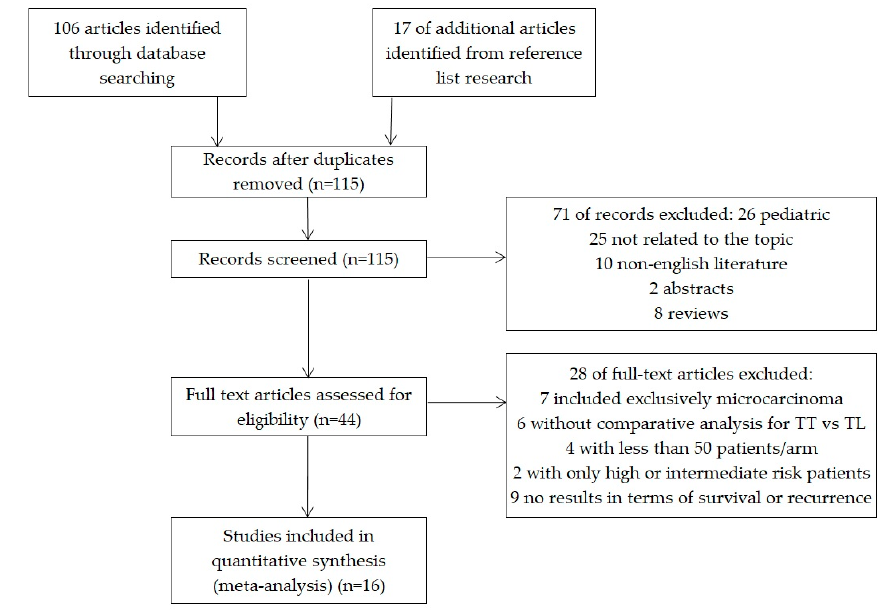
Figure 1. Flow chart for study selection.